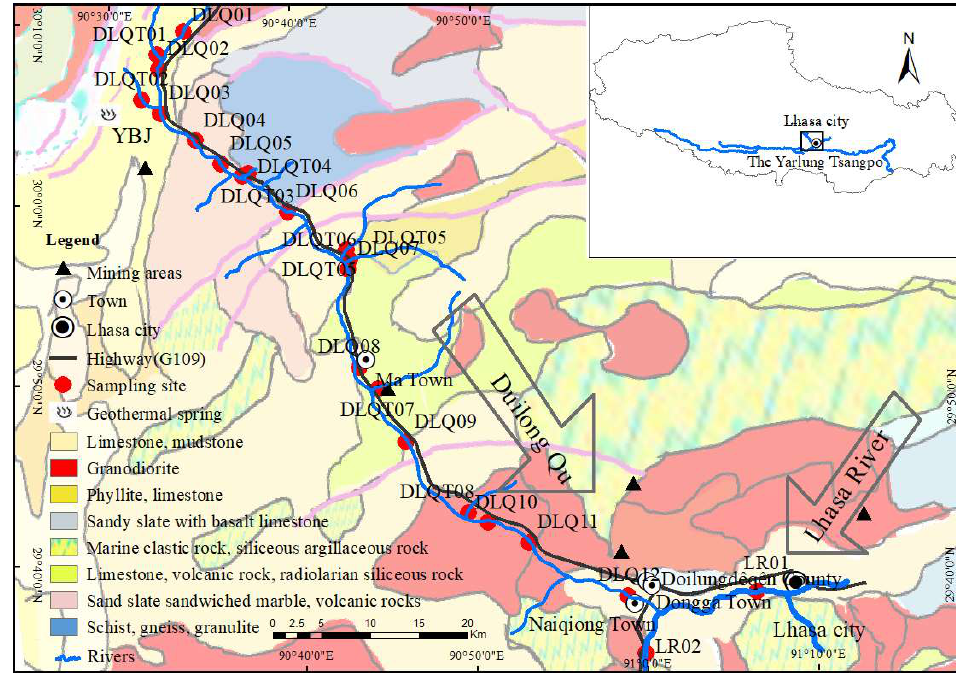
Figure 1. Distribution of Sampling sites in DLQ.